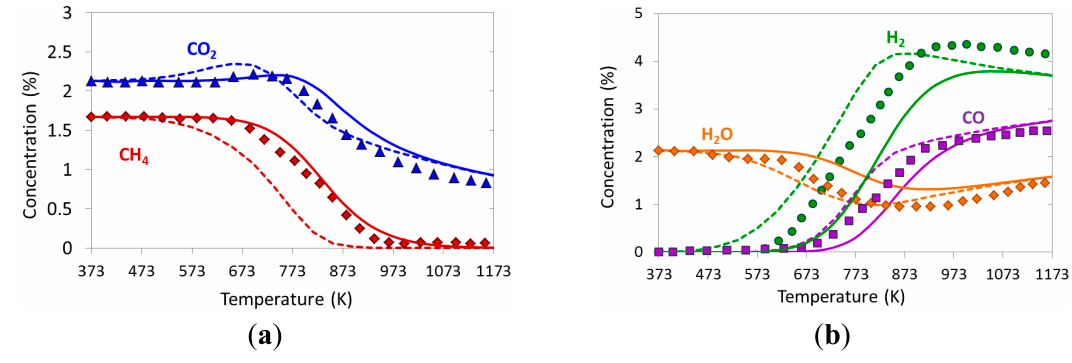
Figure 14. Comparison of experimentally determined (symbols) and numerically predicted (lines) concentrations as a function of temperature for catalytic dry reforming of methane with co-feed H 2 O: ( a ) CH 4 , and CO 2 ; ( b ) H 2 O, CO, H 2 , inlet gas composition of 1.7 vol.% CH 4 , 2.1 vol.% CO 2 , 2.1 vol.% H 2 O in N 2 ; 1 bar; T inlet = 373 K, total flow rate of 4 slpm, dashed lines = equilibrium composition at given